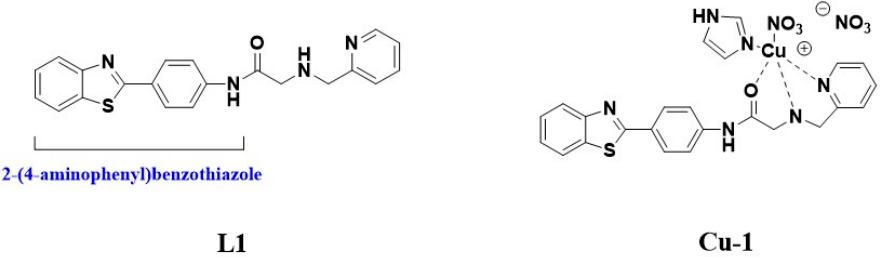
Figure 1. The structures of the 2-(4-aminophenyl)benzothiazole-bearing ligand ( L1 ) of this work and its corresponding Cu(II) complex ( Cu-1